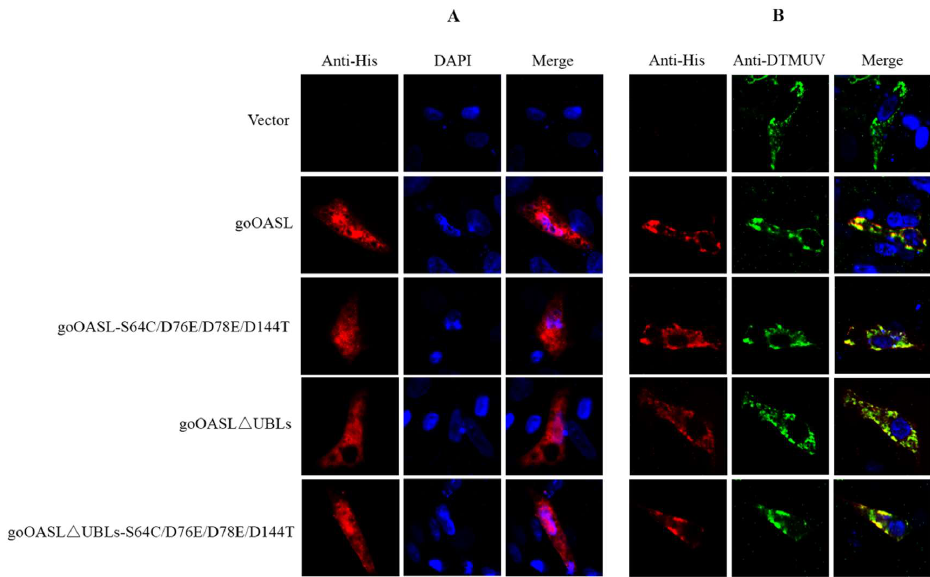
Figure 5. Cellular localization of goOASL and its mutant proteins in DEFs. ( A ) Cellular localization of goOASL and its mutant proteins in normal DEFs. DEFs seeded on 20-mm glass slides in a 12-well tissue culture plate were transfected with goOASL, goOASL-S64C/D76E/D78E/D144T, goOASL∆UBLs, or goOASL∆UBLs-S64C/D76E/D78E/D144T (1.6 µg/well). Immunofluorescence was detected at 36 h after transfection via fluorescence microscopy. ( B ) Cellular colocalization of goOASL and its mutant proteins in DEFs with DTMUV. DEFs seeded on the 20-mm glass slides in the 12-well tissue culture plate were transfected with goOASL, goOASL-S64C/D76E/D78E/D144T, goOASL∆UBLs, or goOASL∆UBLs-S64C/D76E/D78E/D144T (1.6 µg/well). At 24 h after transfection, the cells were infected with DTMUV (10 4 TCID 50 /well) for another 12 h. Immunofluorescence was detected using fluorescence microscopy. The rabbit anti-His antibody and mouse anti-DTMUV antibody were used as primary antibodies, the TRITC-goat anti-rabbit IgG and FITC-goat anti-mouse IgG were used as secondary antibodies. DAPI was used for nucleolus staining. Fluorescence (red, green and blue) was detected via fluorescence microscopy (magnification 600×) and analysed using Image Pro Plus 6.0.